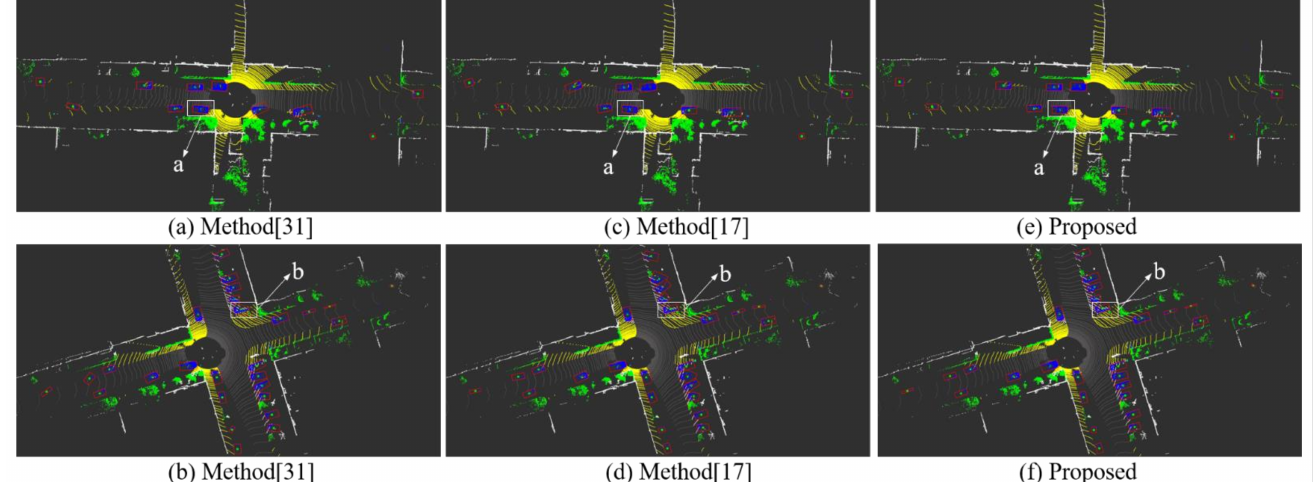
Figure 21. The pose estimation results in the SemanticKITTI dataset. The ( a , c , e ) represents the experiment result on a straight road section, and the ( b , d , f ) represents the experiment result on a curved road section.